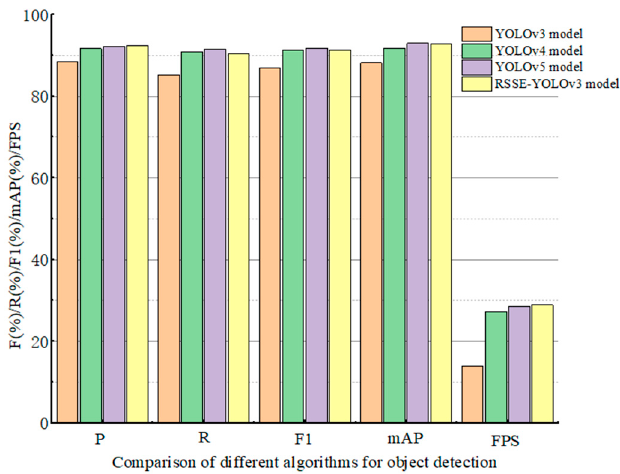
Figure 6. Comparison of histograms of test results of different algorithms.